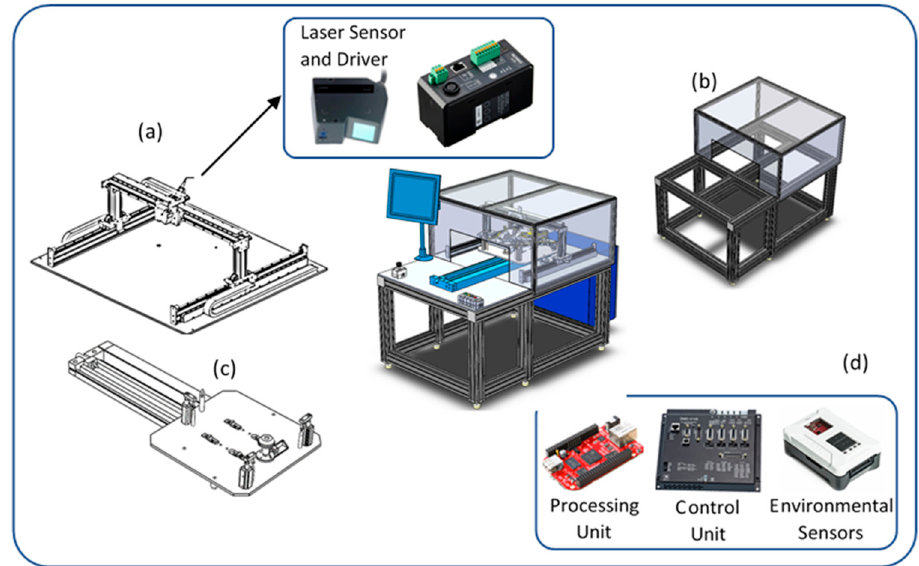
Figure 6. In-Line Measurement Machine. ( a ) Cartesian 2 axis Positioner, ( b ) machine structure, ( c ) pneumatic part positioning system, and ( d ) control system.